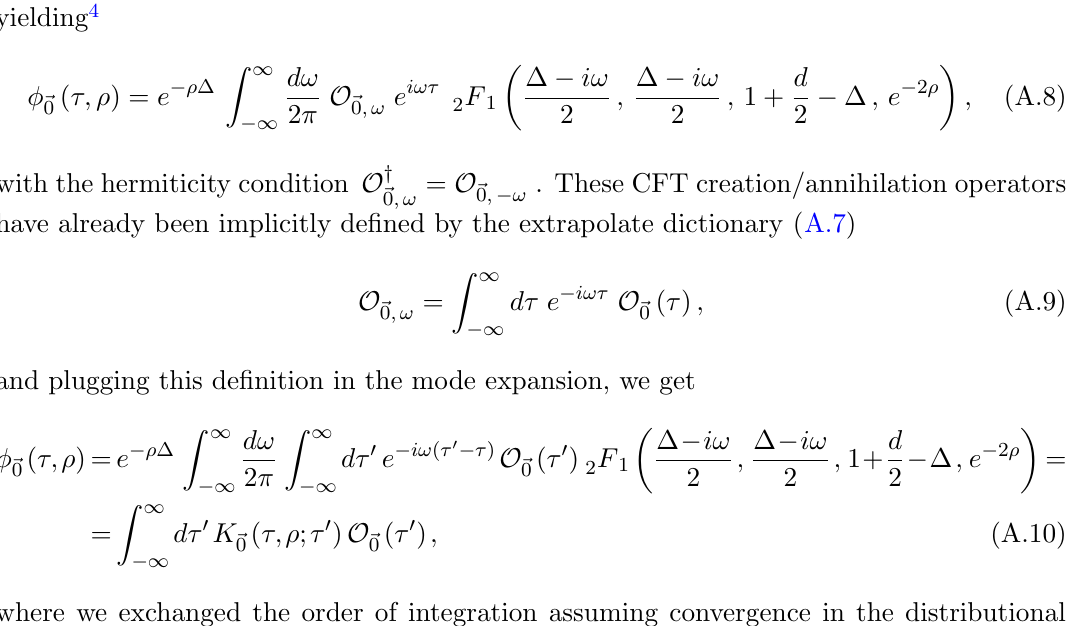
Figure 10 . The ( (cid:28); (cid:26) ) coordinate system faithfully covers region I. Horizontal (vertical) dashed lines are constant (cid:28) (constant (cid:26) ). The CFT singularity happens in(cid:12)nitely far in the past. In order to solve (A.6), we (cid:12)rst rescale the mode (cid:8) perform a change of variable (cid:27) = e 2 (cid:26) , to reduce the equation into the hypergeometric equation. It can be solved around the (cid:26) = 1 pole with the correct asymptotic behavior, yielding